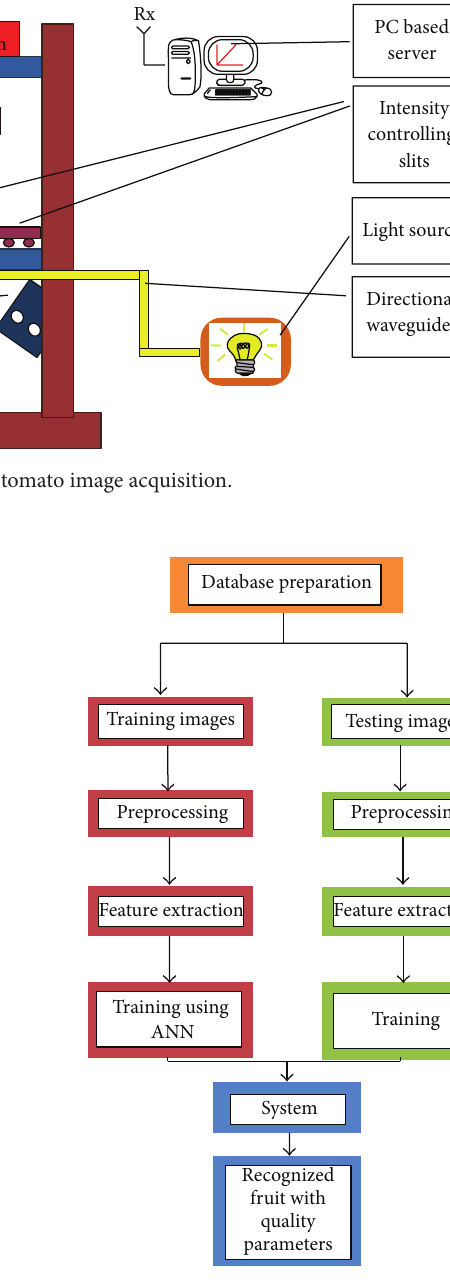
Figure 4: Proposed algorithm for vision sensing